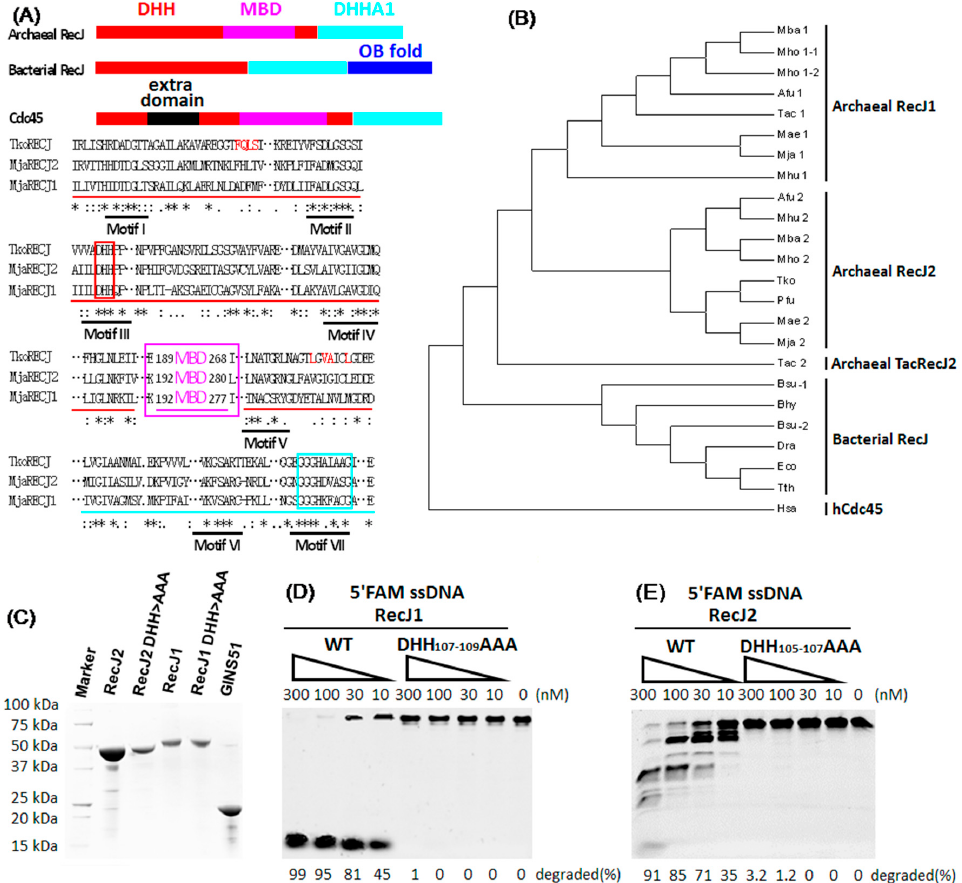
Figure 1. Two RecJs from Methanocaldococcus jannaschii demonstrate nuclease activity. ( A ) Multi- alignment of three archaeal RecJs. The domain combinations of archaeal and bacterial RecJs, and eukaryotic Cdc45 protein is compared on the top of panel A, and the names of each domain are indicated. For multi-alignment of RecJs, red, purple and cyan lines are used to represent the domains of DHH, MBD, DHHA, respectively. The conserved motifs are marked by black lines, and the motifs of DHH and DHHA1 are highlighted with red and cyan box, respectively. The middle domain, the MCM helicase Binding Domain (MBD) and its boundary are highlighted by a purple box with the indicated number of residues. The residues responsible for interaction with GINS51 subunit are shown in red. ( B ) The phylogenetic tree of RecJ homologs is built based on multi-alignment of these sequences. Archaeal RecJ1 and RecJ2 are classified based on their sequence similarity to M. jannaschii RecJ1 and RecJ2. RecJ homologs come from archaea of Methanocaldococcus jannaschii DSM 2661 (Mja), Methanococcus aeolicus Nankai-3 (Mae), Methanospirillum hungatei JF-1 (Mhu), Methanosarcina barkeri strain (str.) Fusaro (Mba), Thermoplasma acidophilum DSM 1728 (Tac), Archaeoglobus fulgidus DSM 4304 (Afu), Methanomethylovorans hollandica DSM 15,978 (Mho), Pyrococcus furiosus DSM 3638 (Pfu), and Thermococcus kodakarensis KOD1 (Tko); bacteria of Deinococcus radiodurans R1 (Dra), Thermus thermophilus HB8 (Tth), Bacillus subtilis str. 168 (Bsu), Escherichia coli K12 (Eco), and Brachyspira hyodysenteriae WA1 (Bhy); human Cdc45 (Hsa). ( C ) Expression and affinity purification of five M. jannaschii recombinant proteins. Increased amounts of wild-type (WT) or DHH motif mutated MjaRecJ1 ( D ) or MjaRecJ2 ( E ) were incubated with 200 nM 23 nt 5 ′ FAM-labeled ssDNA substrates at 55 °C for 20 min in a standard reaction buffer. The degraded amount of substrate was quantified and listed at the bottom of the panel.